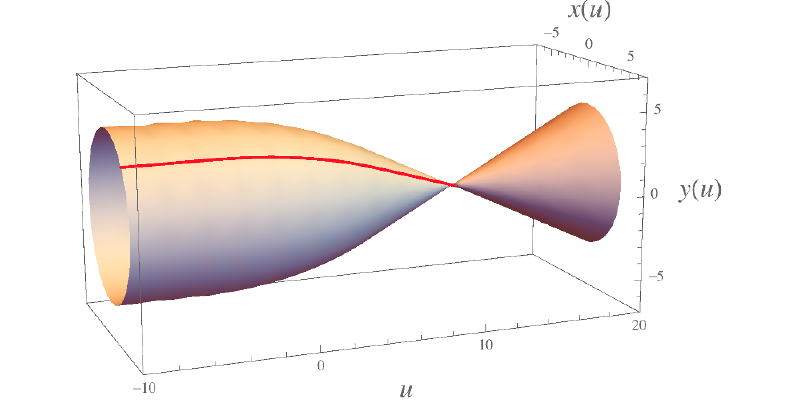
Figure 4 . The red curve shows the trajectory of a geodesic in the background of a gravitational wave burst with extended pro(cid:12)le (cid:2)( u; L ). The parameters match those of the r ( u ) plots in (cid:12)gure 2. The shaded surface is mapped out by geodesics with the same impact parameter b but with di(cid:11)erent angles (cid:30) around the gravitational wave source on the r = 0 axis. The focusing e(cid:11)ect for geodesics with the same impact parameter is evident.